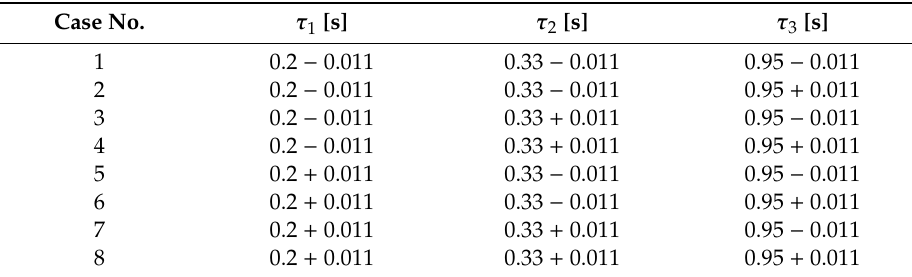
Table 2. Igniters’ uncertainty combinations.